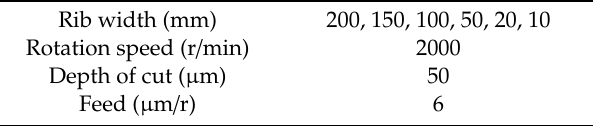
Table 5. Machining condition of micro cutting to optimize the rib width.